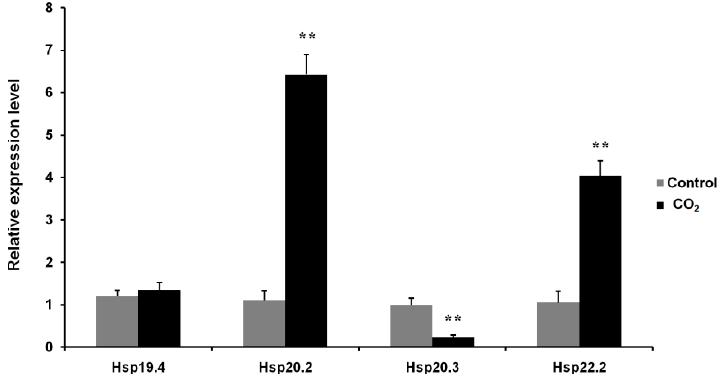
Figure 8. Relative expression levels of four LsHsp genes in L. serricorne in response to CO 2 stress. Adults were collected for qPCR analysis at 6 h after exposure to air containing 70% CO 2 . The control group was maintained under natural atmospheric conditions. Significant differences between the treatment and control were determined using a t test and indicated by ** ( p < 0.01).